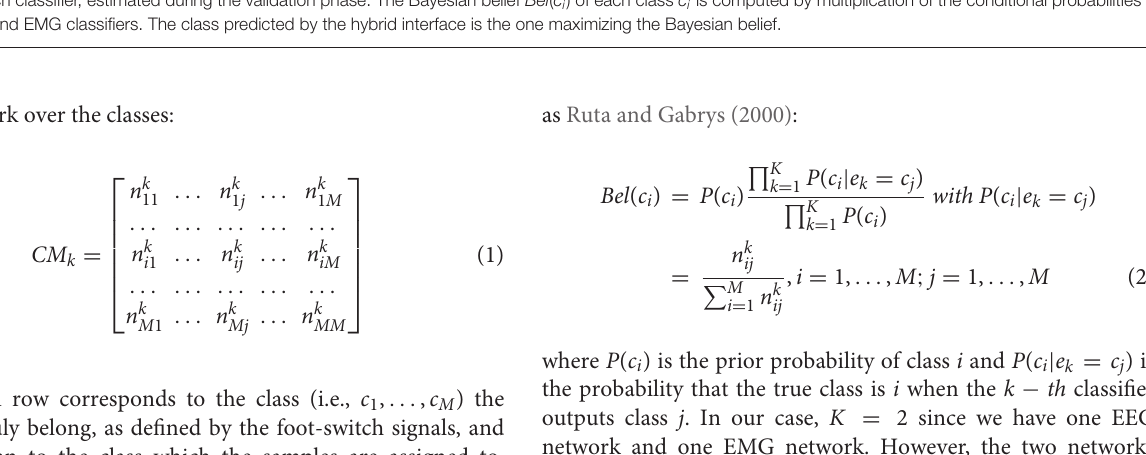
, c EMG ) given the predicted class ( c EEG , c EMG ) from the confusion i i j j